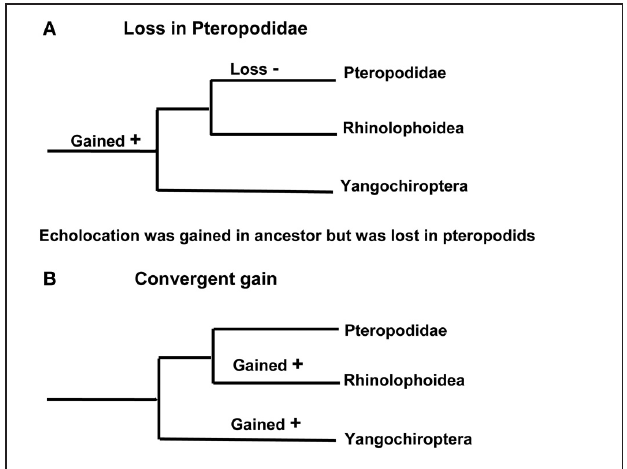
FIGURE 2 | Alternative hypotheses for the evolution of laryngeal echolocation. (A) Phylogenetic tree showing a single loss in the Old World fruit bats. (B) Phylogenetic tree in which echolocation was acquired independently by more than one lineage.